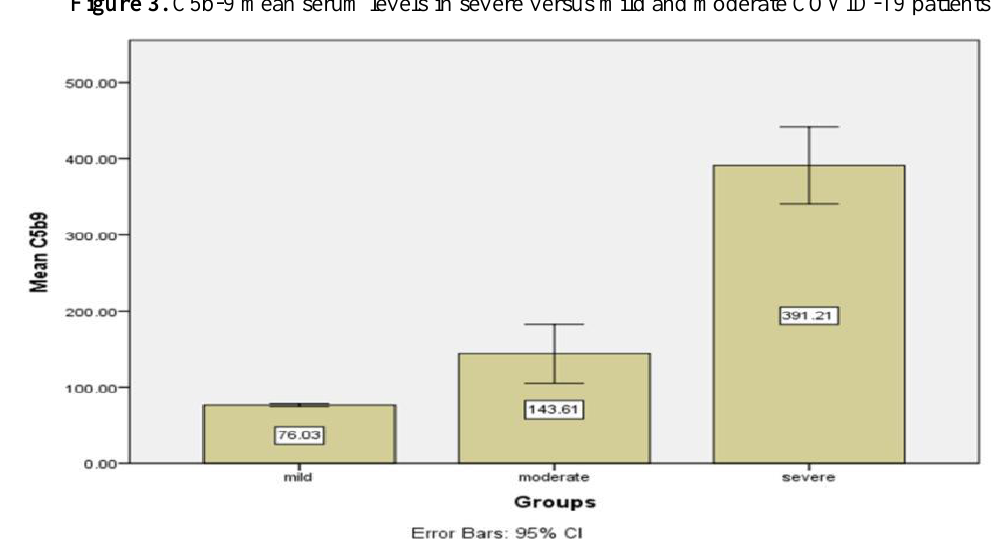
ean serum levels in severe versus mild and moderate COVID-19 patients.